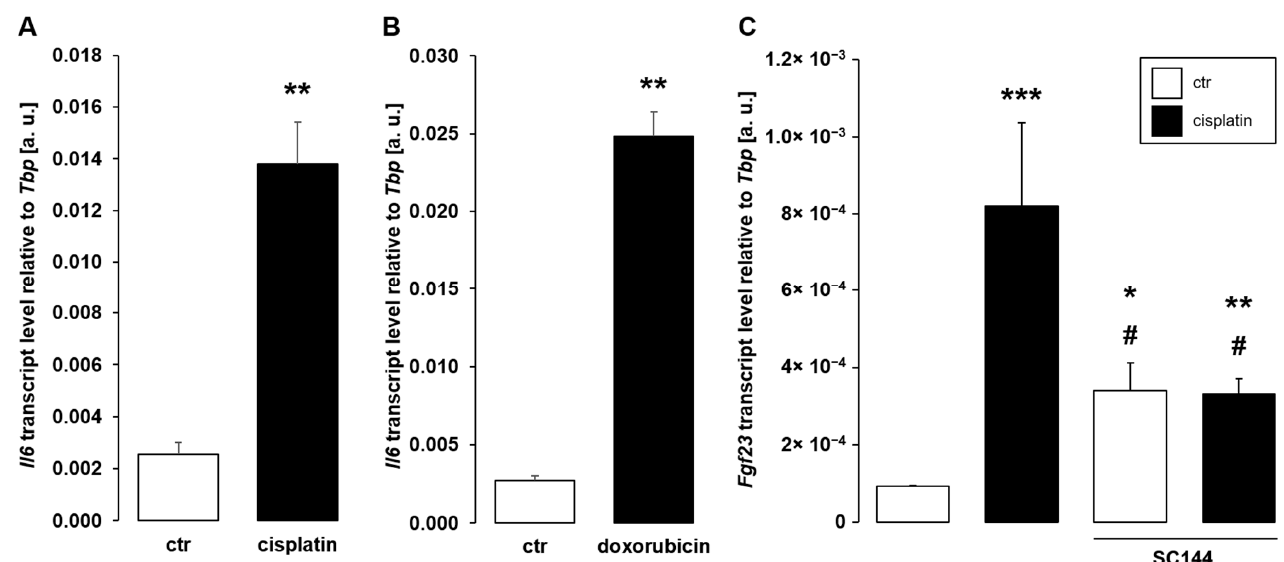
Figure 5. Interleukin-6 (IL-6) signaling inhibitor SC144 attenuated cisplatin-induced Fgf23 gene expression in UMR106 cells. ( A , B ): Arithmetic means ± SEM of interleukin-6 ( Il6 ) mRNA levels relative to Tbp in UMR106 cells treated without (ctr) or with 10 μ M cisplatin (( A ), n = 6; Welch’s test) or 0.3 μ M doxorubicin (( B ), n = 6; Mann–Whitney U test) for 24 h. ( C ): Arithmetic means ± SEM of Fgf23 transcript levels relative to Tbp in UMR106 cells treated without (ctr) or with 10 μ M cisplatin in the presence or absence of 1 μ M Il ‐ 6 signaling inhibitor SC144 ( n = 9; Kruskal–Wallis followed by Dunn–Bonferroni test) for 24 h. * p < 0.05, ** p < 0.01, *** p < 0.001 indicate significant differences from vehicle ‐ treated cells (1st bar); # p < 0.05 indicates significant difference from absence of SC144 (2nd bar vs. 4th bar). a. u., arbitrary units; ctr, control.